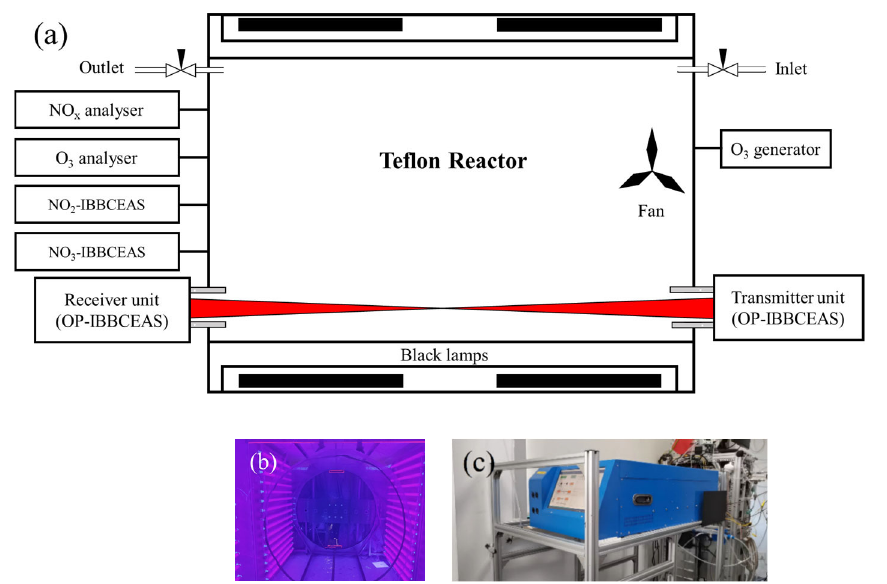
Figure 3. ( a ) Schematic of SAES-ARC facility. ( b ) SAES-ARC with black lamps on. ( c ) Extractive NO 3 ‐ IBBCEAS.